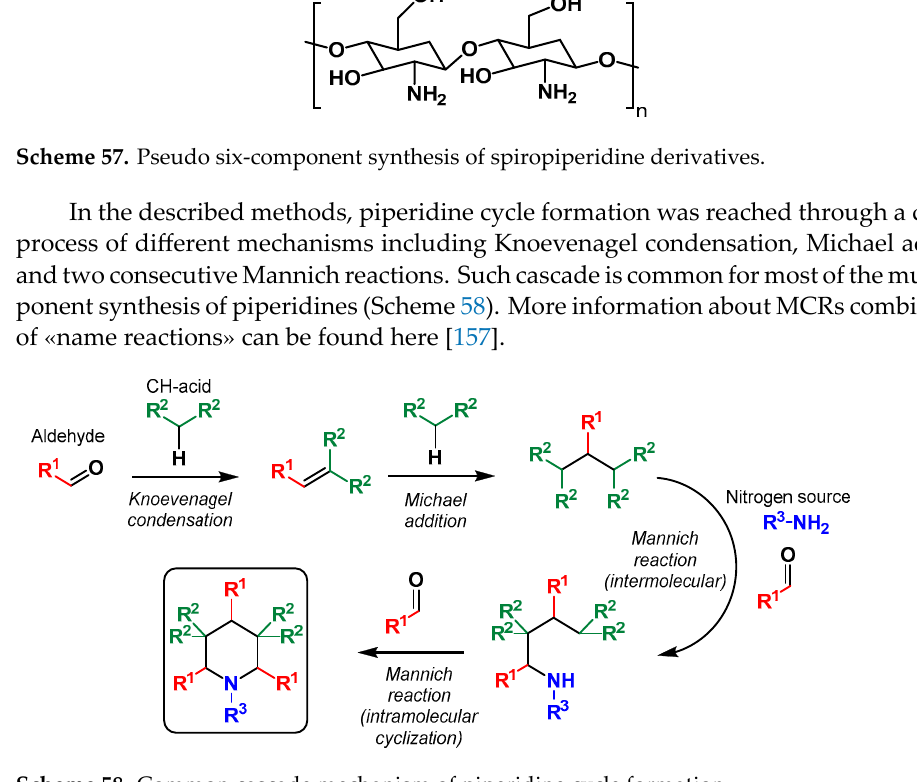
Scheme 57. Pseudo six-component synthesis of spiropiperidine